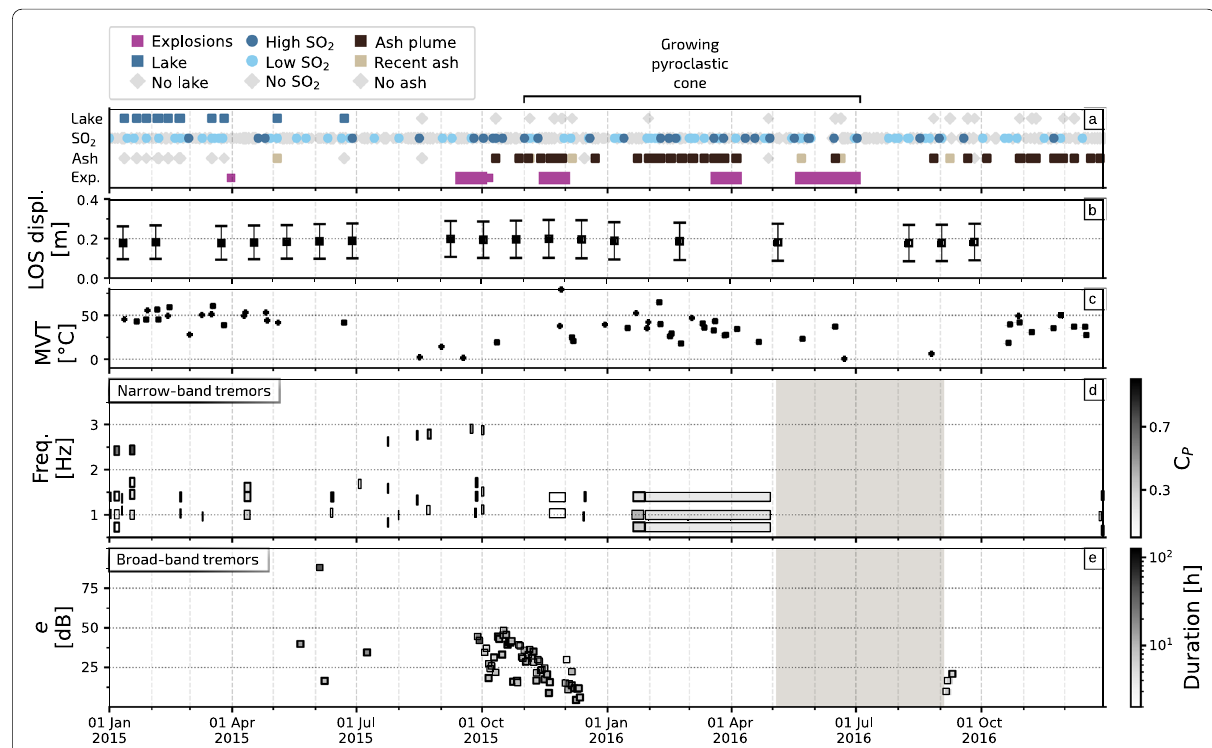
Fig. 11 Time evolution of ( a ) surficial activity, b LOS-displacement, c LST temperature, d frequency and C P of dominant frequencies of NB tremors, and e energy of BB tremors for the periods January 2015 to December 2016. Gray shadows in c and d depict periods without seismic